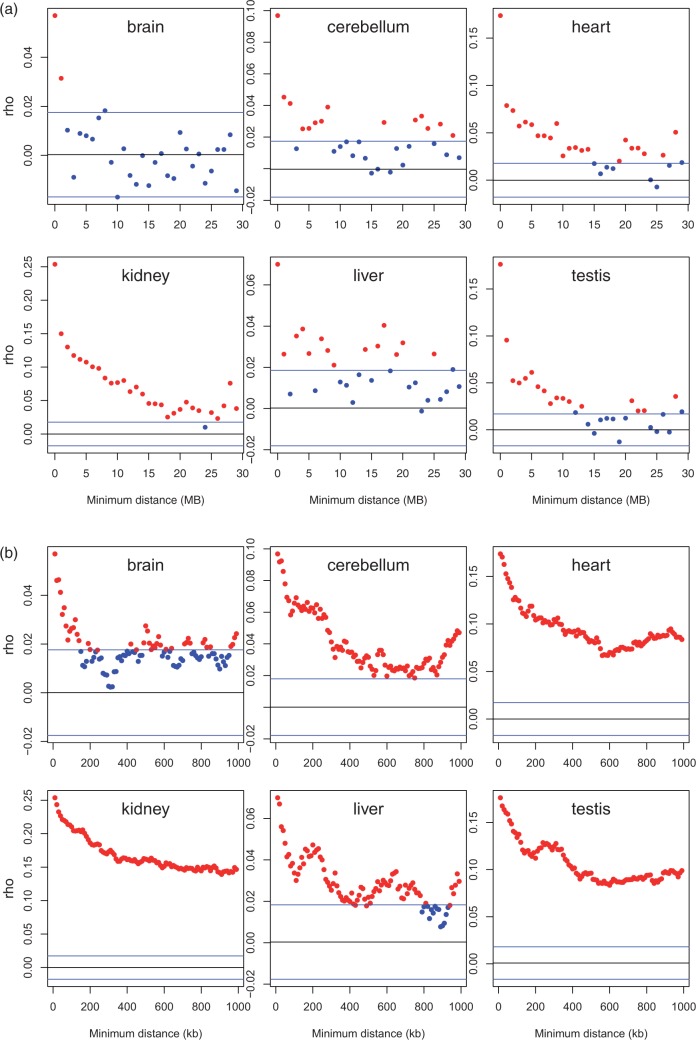
Correlation between Z of each focal gene and Z of nearest downstream neighbor more than a given minimum physical distance away. (a) We plot data considering increments of minimum distance 1 MB at a time up to a maximum of 30 MB. (b) We consider 10-kb increments up to a maximum of 1 MB. For each focal gene we extract the nearest neighbor downstream that is at least the distance x away, x being the units on the x axis. From a list of focal and neighbor Z scores, we consider then the correlation between these. Correlations significant at the 0.05 level are shown in red, otherwise in blue. The blue horizontal lines indicate 1.96 SD limits determined by randomization (which should in principle correspond with the P from Spearman’s ρ), with the black line indicating mean of null expectation from randomization (which should be around zero).